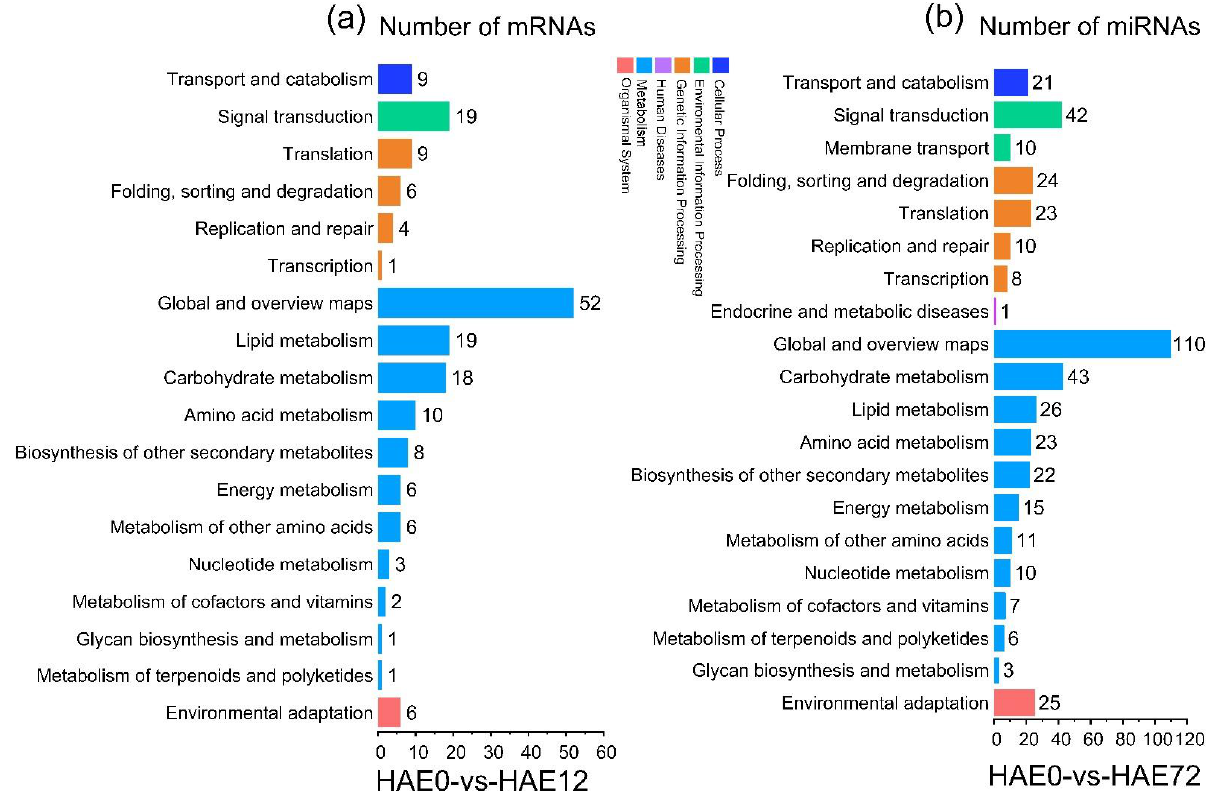
Figure 5. KEGG classification of differentially expressed genes (DEGs) and differentially expressed microRNAs in HAE0-vs-HAE12 and HAE0-vs-HAE72 comparison libraries. ( a ) The number of DEGs in HAE0-vs-HAE12 libraries. ( b ) The number of DE miRNAs in HAE0-vs-HAE72 libraries. The x-axis represents the number of DEGs and DE miRNAs. The y-axis shows the KEGG pathway terms in DEGs and DE miRNAs.